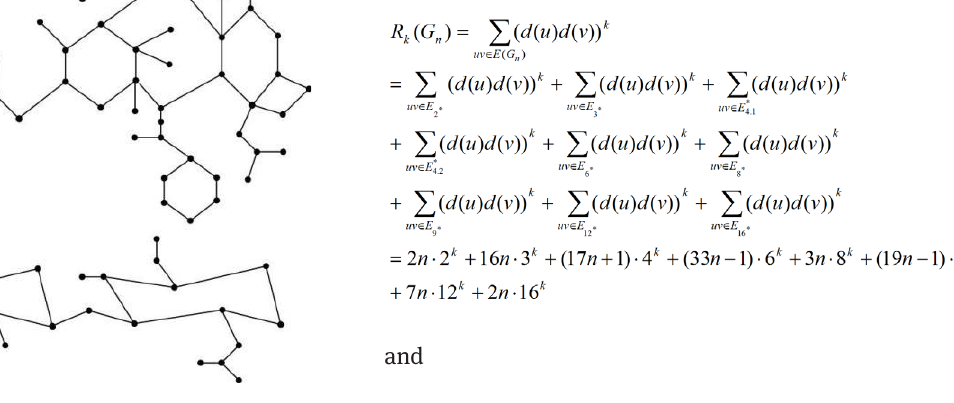
Figure 2: Corresponding molecular graph G